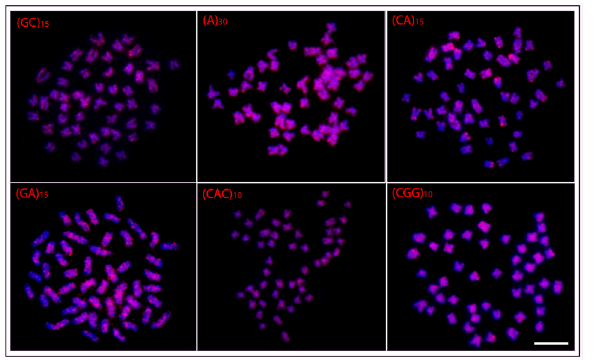
Figure 3 – Hybridization patterns with microsatellites probes (red signals) on metaphase plates of Osteochilus lini . Chromosomes were counterstained with DAPI (blue). Scale bar = 5 μm.